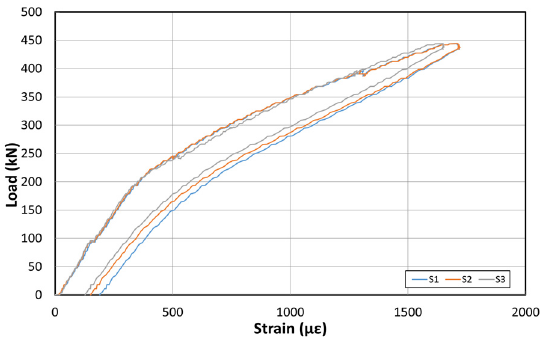
Figure 13. Inner tendon strain curve at the bottom before reinforcement based on the EP method.